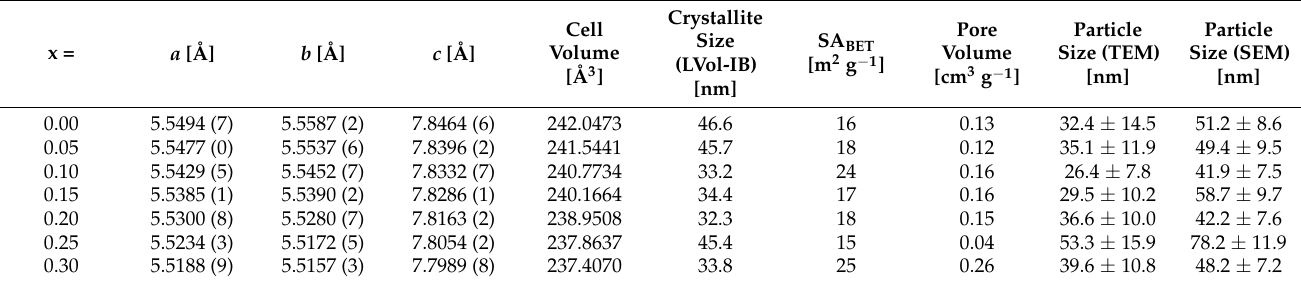
Table 1. Characterization data of the samples after calcination, including Rietveld refinement, surface area, pore-volume, and particle size. The crystallite size was determined as the volume-weight mean column height from integral breadth.